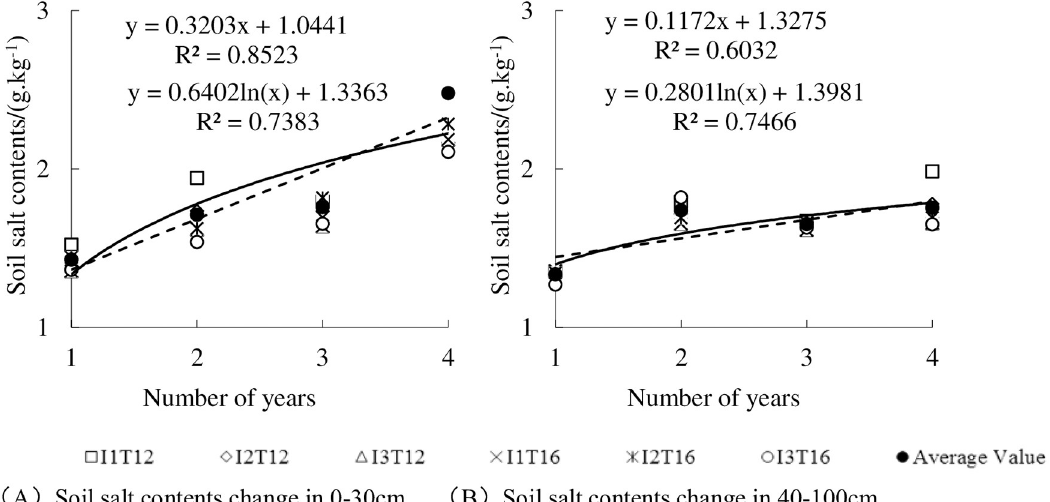
Fig 2. Soil salinity changes with the age of drip